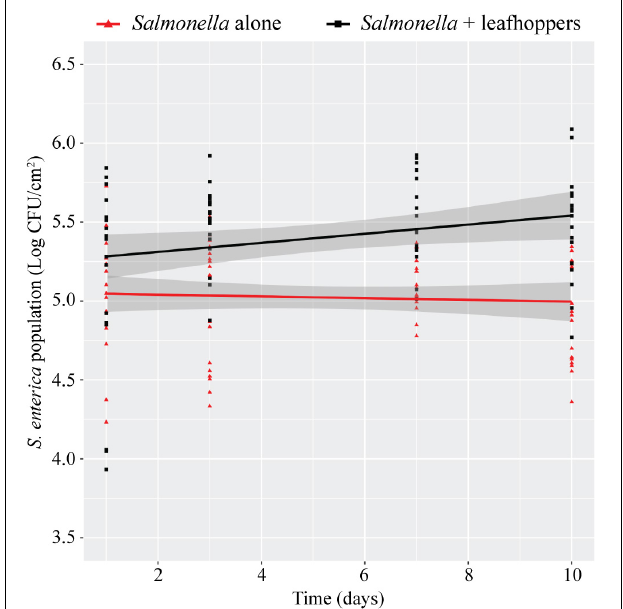
FIGURE 2 | Leafhopper infestation leads to increased persistence of S. Typhimurium populations. Bacterial populations on leaves were monitored over time either in the presence (black squares) or absence (red triangles) of leafhoppers. All data points from three independent experiments were combined and presented as S. Typhimurium populations (log CFU/cm 2 ) over a 10-day period. Lines (black, S. Typhimurium with leafhoppers; red, S. Typhimurium alone) correspond to a linear regression model, and shaded areas correspond to the respective 95% confidence